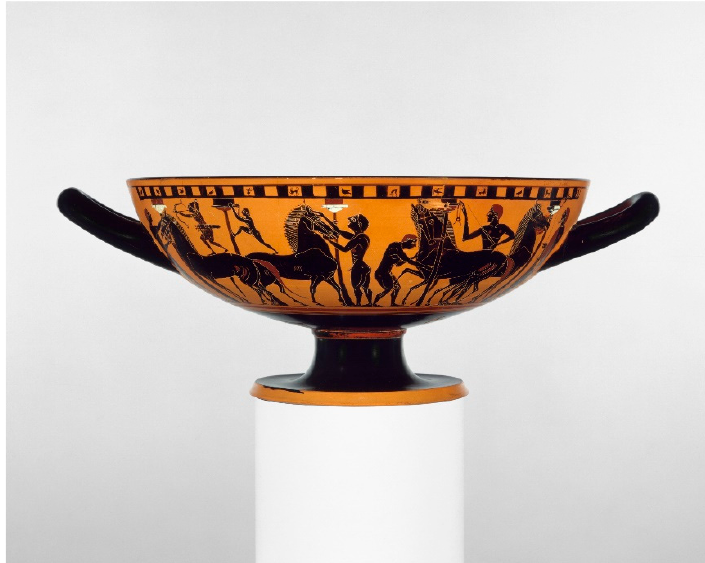
Figure 17. Kylix, “Poseidon’s Stable”. Attributed to the Amasis Painter. Ca. 540 BCE. Metro-politan Museum of Art. Gift of the Norbert Schimmel Trust, 1989. Inv. no. 1989.281.62.